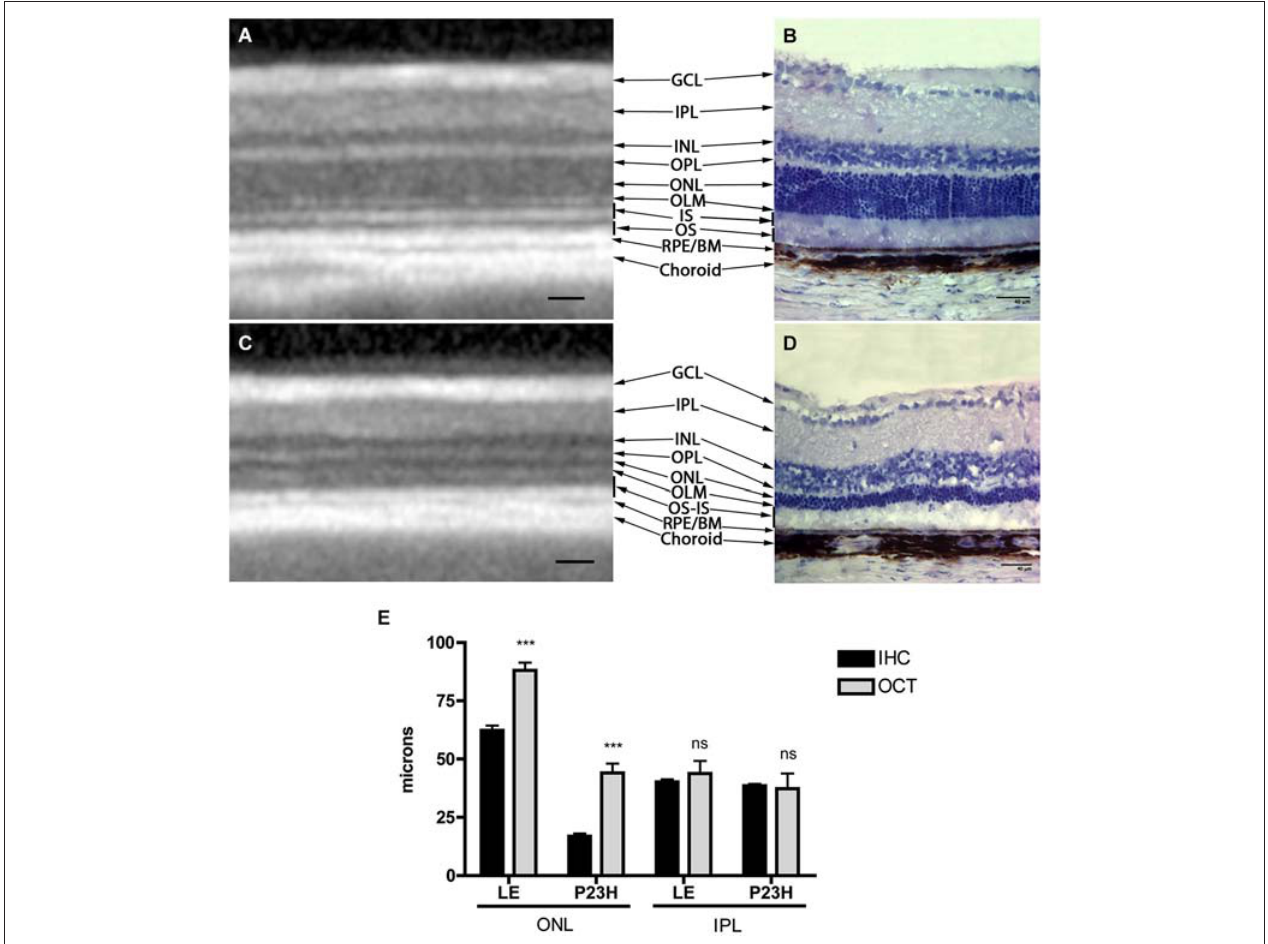
retinal layers measured by immunohistochemistry and OCT profiles. (***) p < 0.001. GCL: ganglion cell layer; IPL: inner plexiform layer; INL: inner nuclear layer; OPL: outer plexiform layer; ONL: outer nuclear layer; OLM: outer limiting membrane; IS: inner segments, OS: outer segments; RPE: retinal pigmented epithelium; BM: Bruch membrane. Scale bar: 40 µ